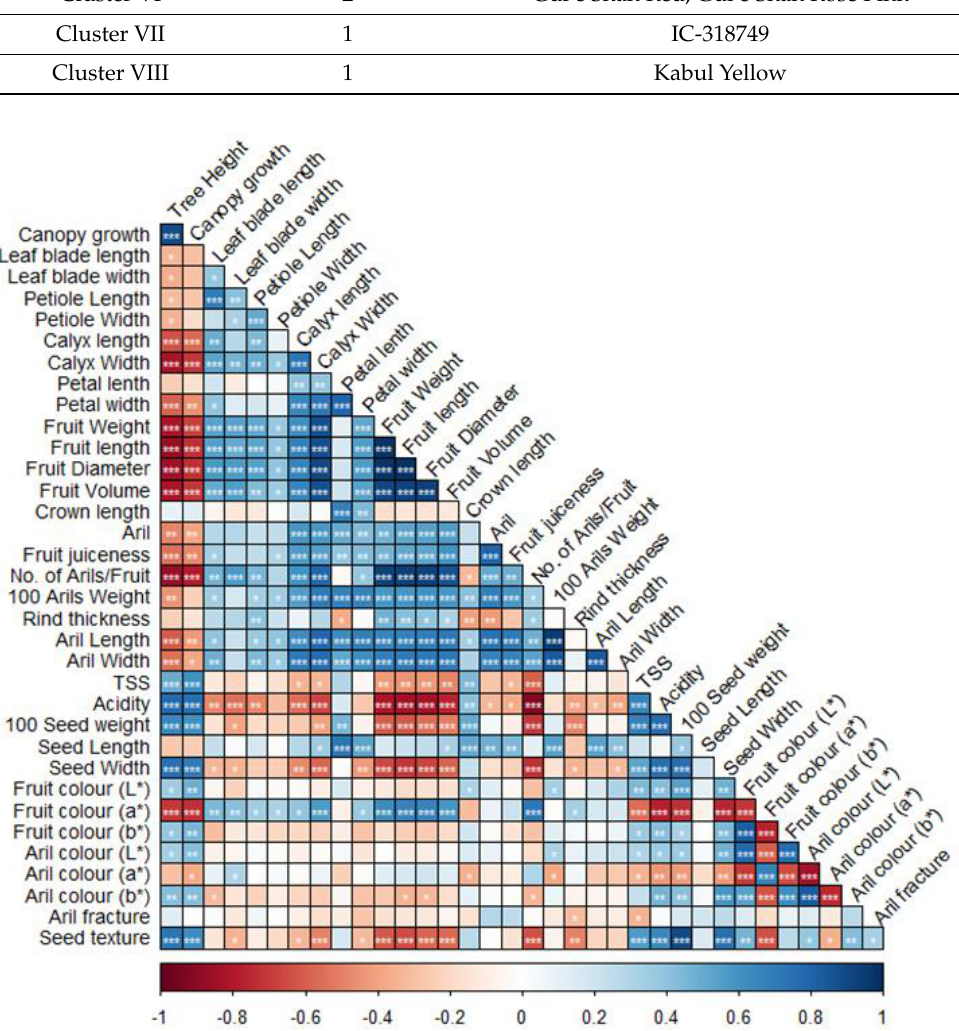
Indian cultivated types were in clusters II, IV, and V. Foreign cultivars introduced from the former USSR (Gul-e-Shah Red and Gul-e-Shah Rose Pink) were grouped in cluster VI, while Kabul Yellow from Afghanistan was the only member of cluster